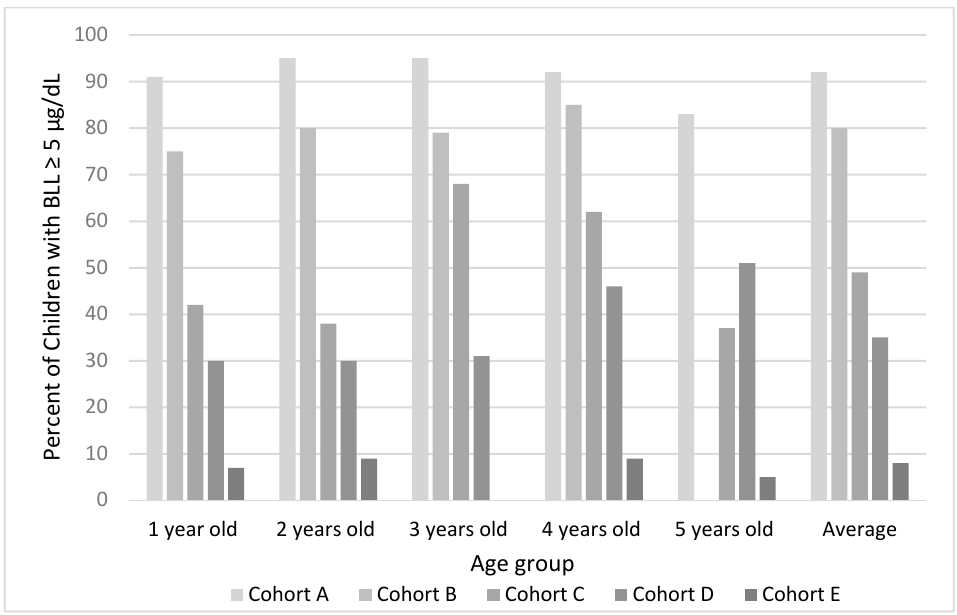
Figure 1. Percent of children with lead in blood concentrations higher than 5 µg/dL for each age group and cohort.